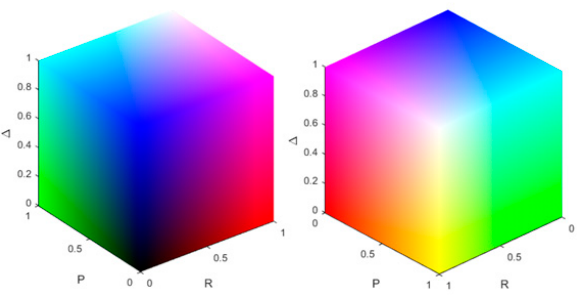
Figure 1. Visualization of colour scheme for all combinations of the intensity of the polarization parameters. The colour channels represent the physical properties obtained through the polar decomposition. The left and right image show the same colour cube from different perspectives.